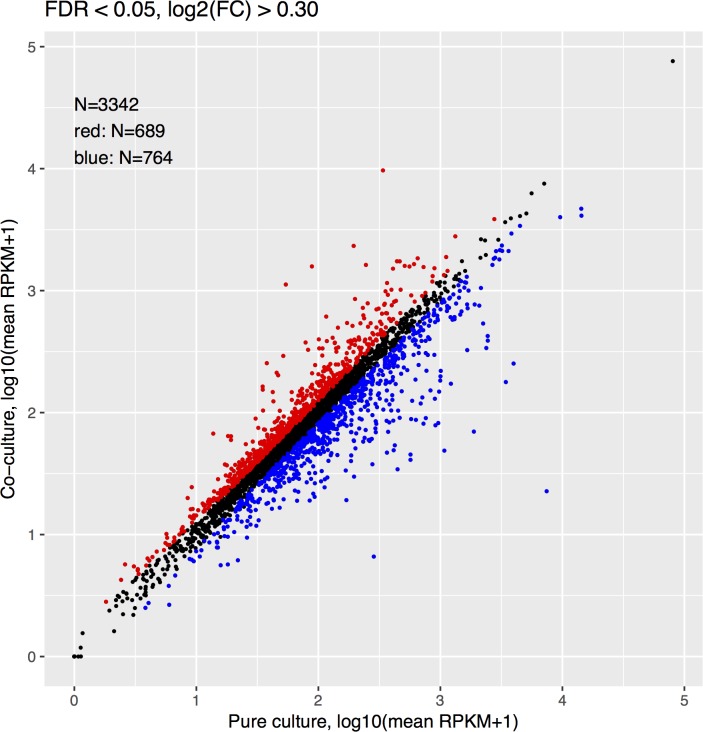
Differential expression of M. caenitepidi Gela4 genes in pure culture and co-culture.Red and blue points represent genes whose expression was upregulated (log2FC > 0.30, FDR < 0.05) and downregulated (log2FC < −0.30, FDR < 0.05), respectively.